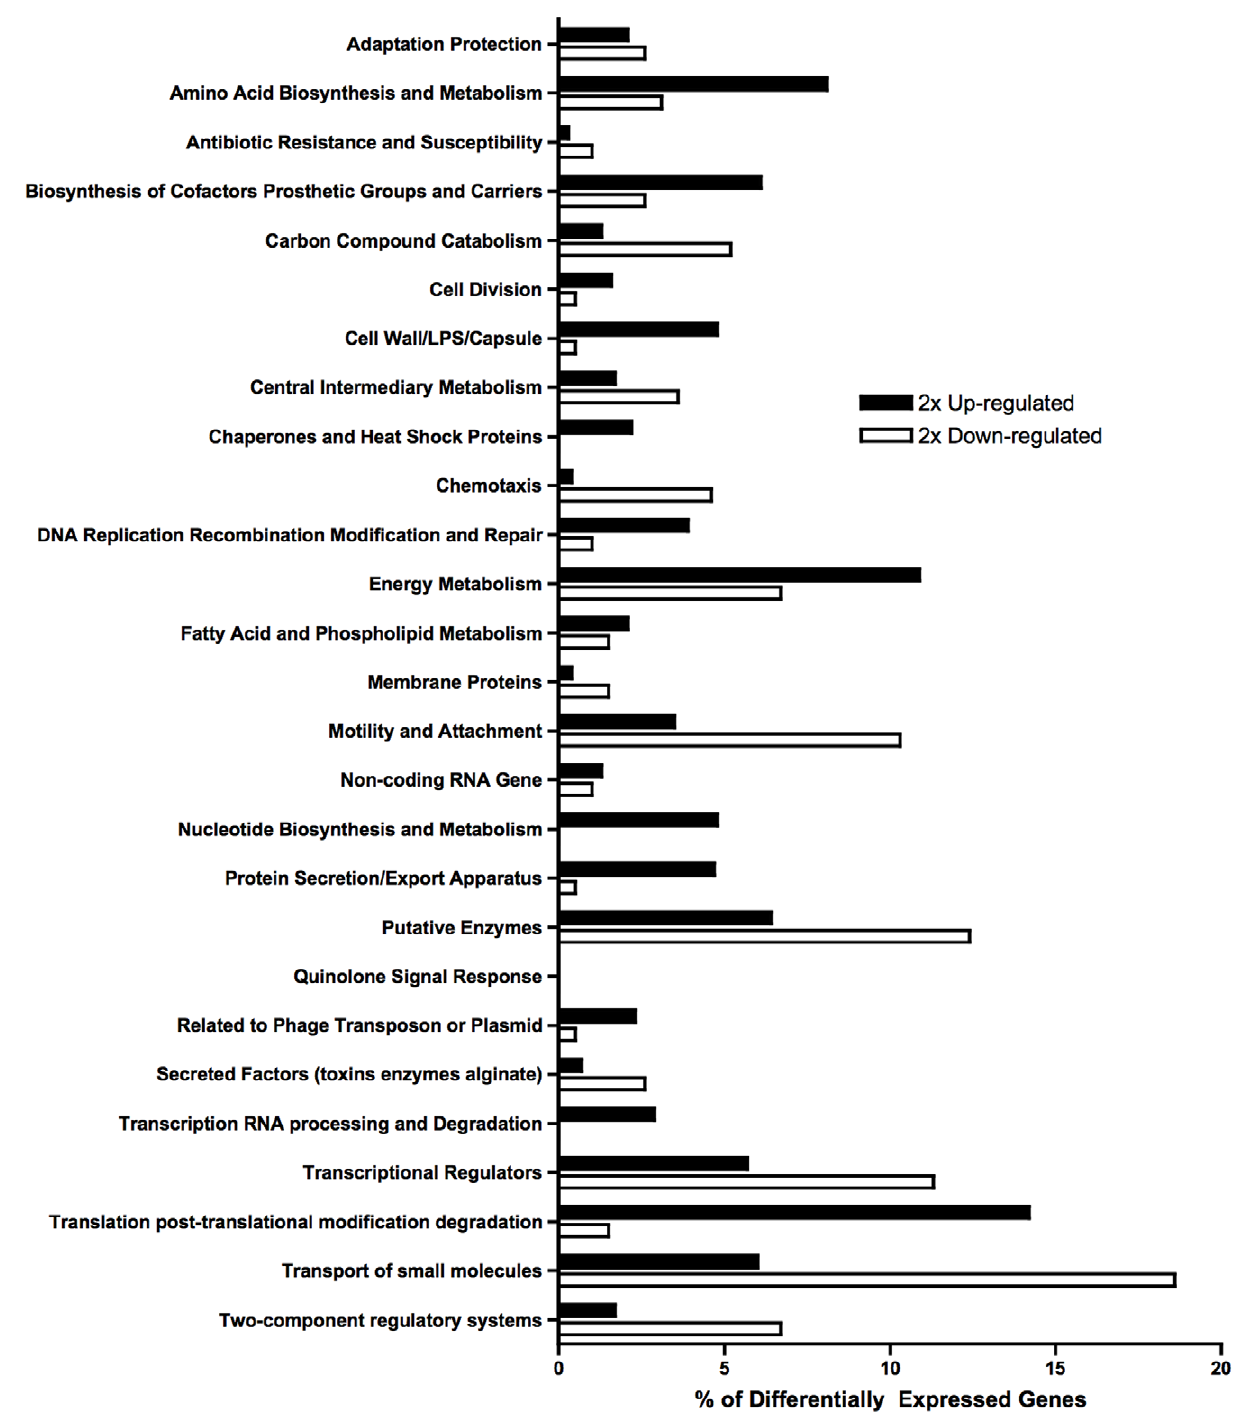
Figure 1. Functional classification of P. aeruginosa (PAK strain) genes differentially expressed in murine gastrointestinal colonization. The functional classes are according to the Pseudomonas Community Annotation Project (www.pseudomonas.com). The percentage of differentially expressed genes is calculated as the number of genes in each class divided by the total number of differentially 2 6 up-regulated or 2 6 down-regulated genes. Note that many genes have more than one functional annotation. LPS, lipopolysaccharide. crc , fleR , pilY1 , flgK , fliP , and pilC ) had comparable biofilm formation and biofilm/growth ratios when grown anaerobically as those produced under aerobic growth conditions (data not shown).